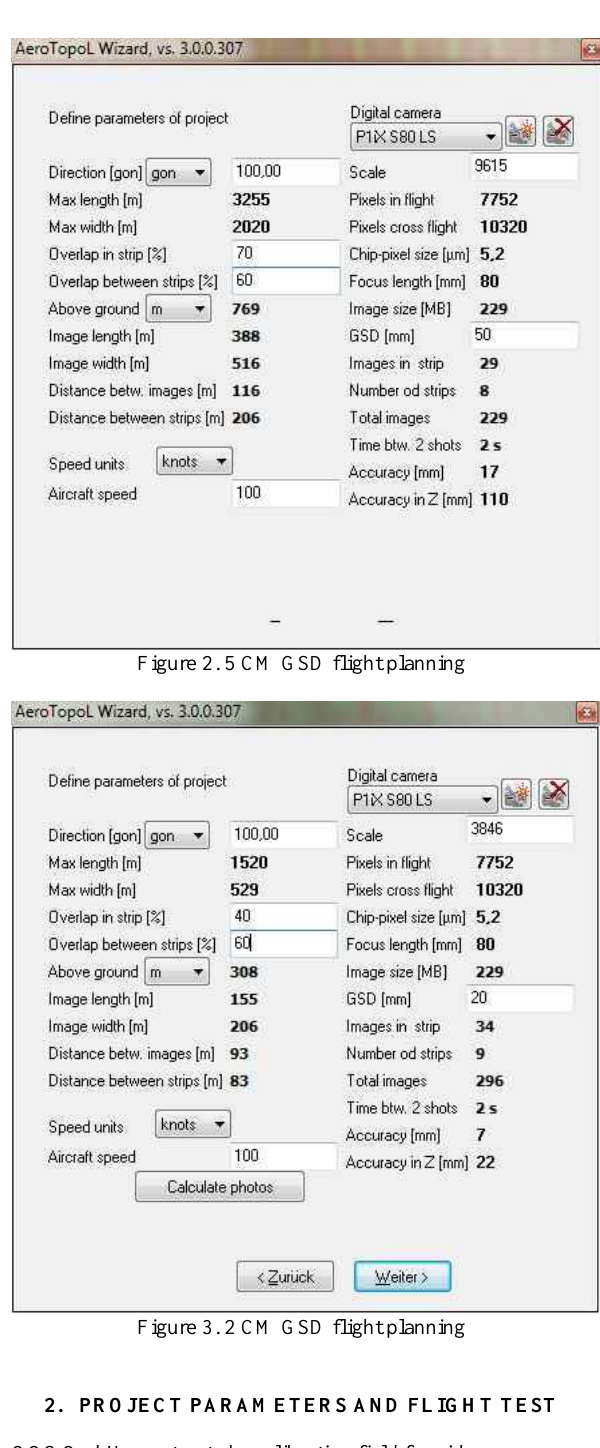
Figure 2. 5 CM GSD flight planning